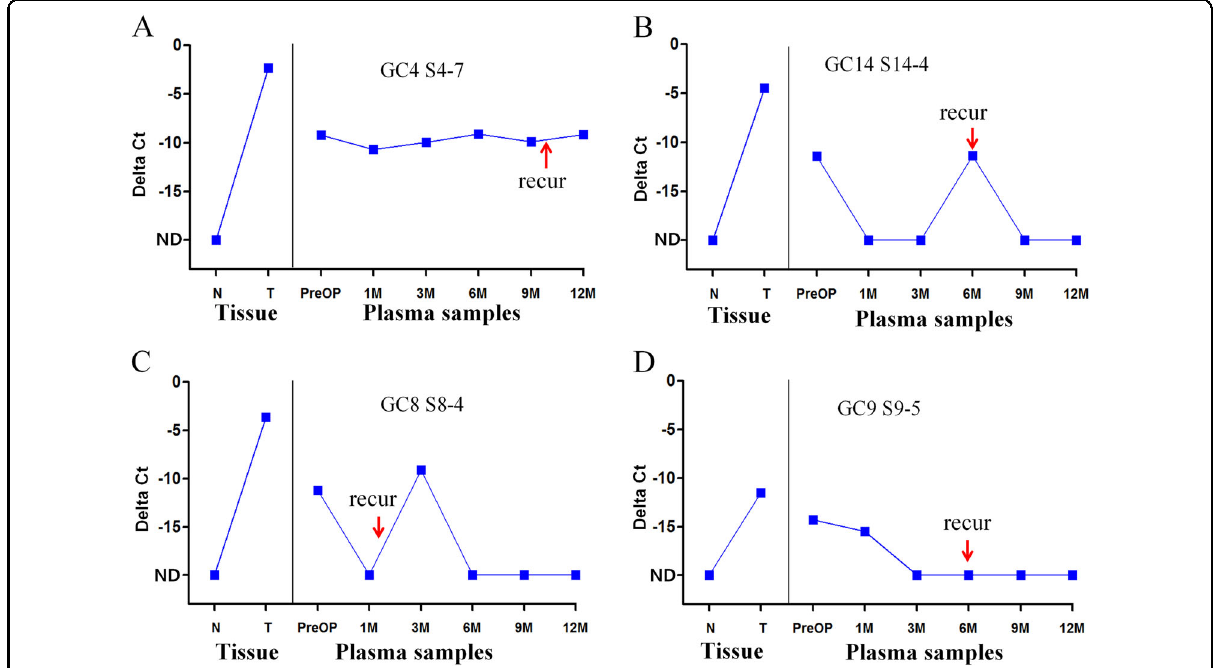
Fig. 4 Quantitative measurements of the ctDNA levels in serial plasma samples from gastric cancer patients. a ctDNA levels in a cancer patient, GC4. b ctDNA levels in GC14. C. ctDNA levels in GC8. D. ctDNA levels in GC9. GAPDH , ampli fi cation control. X -axis, DNAs from normal (N) and cancer (T) tissues and from preoperative (PreOP) and postoperative (PostOp) plasma samples at 1, 3, 6, 9, and 12 months after surgery. Y -axis, delta Ct (the difference in Ct values between the marker and GAPDH ). The arrows indicate the time of clinical recurrence after surgery. ND ,